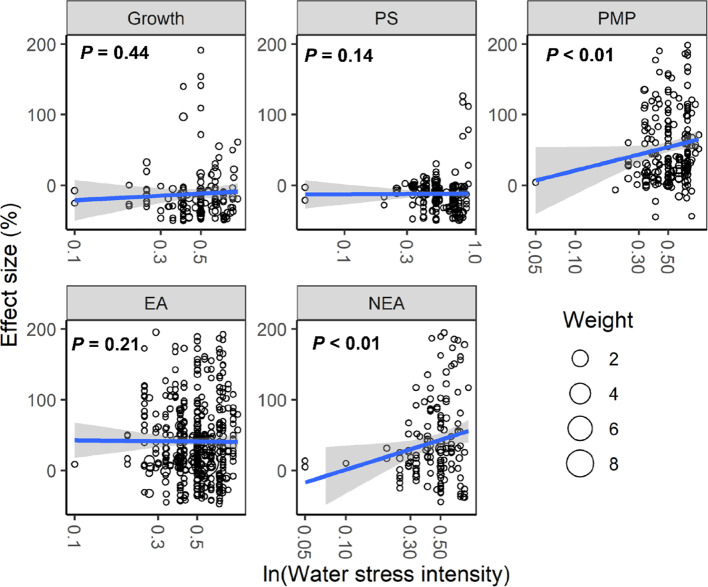
Responses of plant performances to water stress intensity. Linear regressions (blue lines) and their 95% confidence intervals (shaded areas) and corresponding levels of significances (P values) are presented. Circle sizes are proportional to the sampling variances. See 
Figure 2
 for abbreviations.